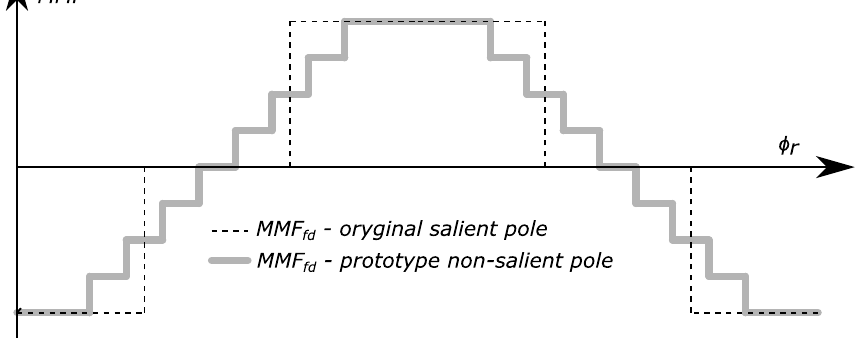
Figure 5. MMF distribution for the commercial and the prototype machine main generator field